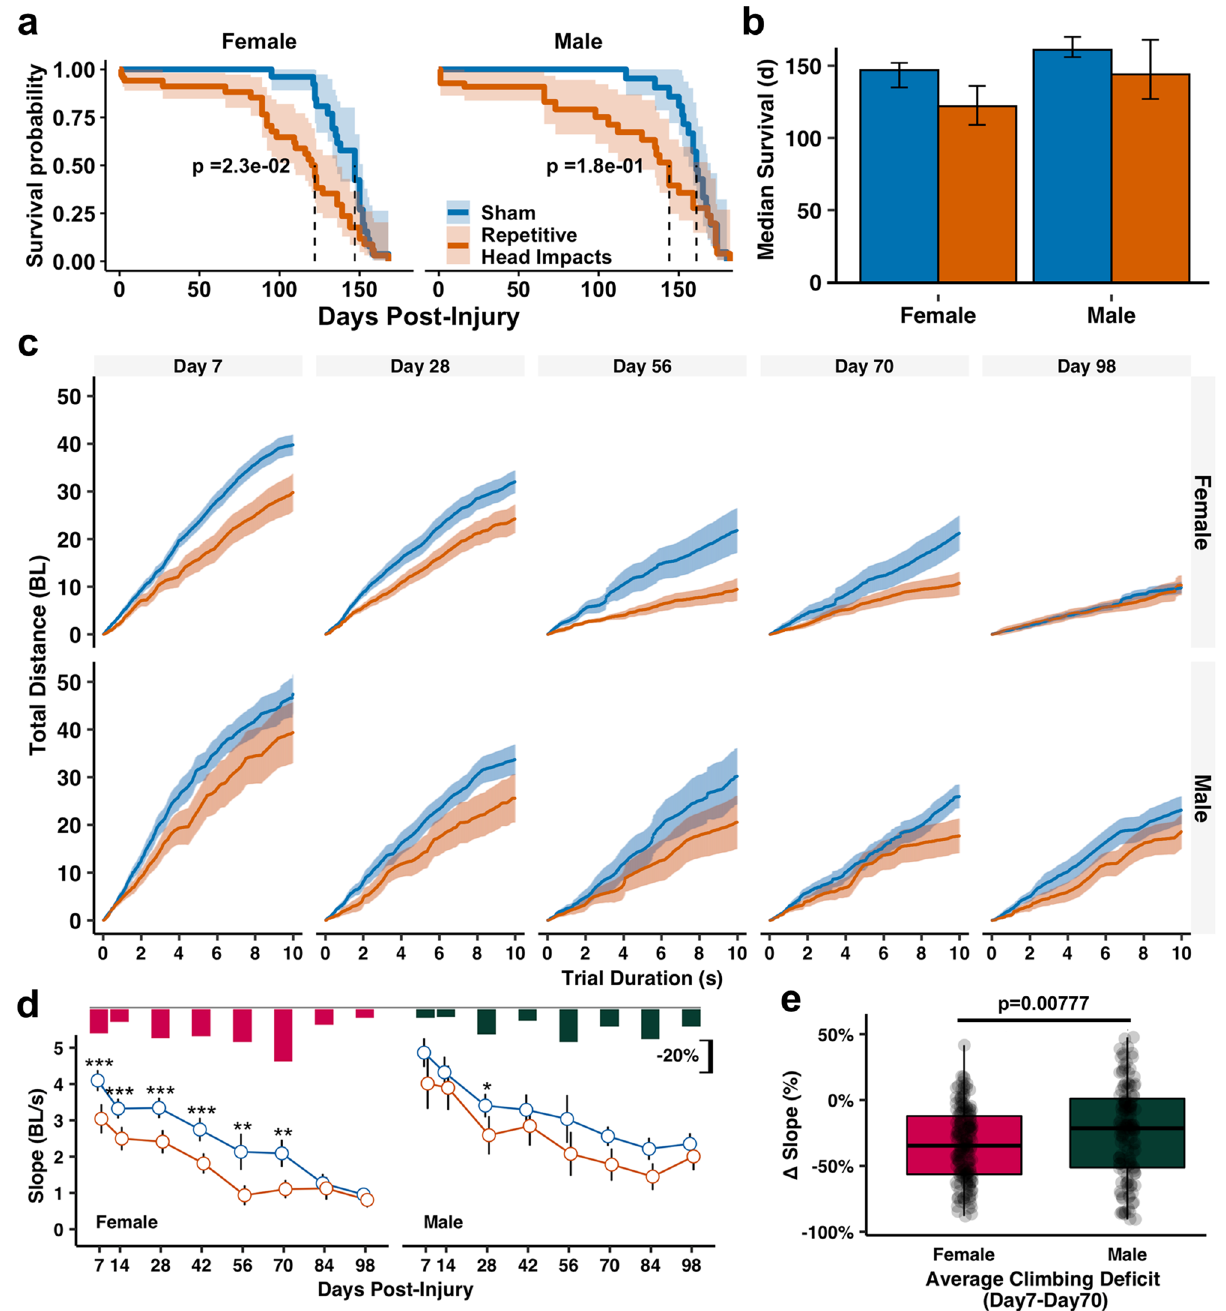
Figure 3. Repetitive head impacts result in a shortened lifespan and long-term behavioral climbing deficits. ( a,b) Repetitive head impacts result in a shortened overall lifespan that is significantly different in injured female flies compared to sham injured flies. Kaplan–Meier p -values were determined using the Mantel-Cox log rank test with Bonferroni correction. ( c–e) Repetitive head impacts exacerbate age-related climbing deficits that are more pronounced in female flies. Plotted values are median with 95% confidence intervals as shaded regions in (c) or error bars in (b,d ) Bar plots in ( d) indicate median relative decrease in climbing performance between injured and sham groups (∆ slope = (Injured Slope-Median Sham Slope)/Median Sham Slope). Boxplots in ( e) contain individually plotted ∆ slope values with whiskers corresponding to the maximum 1.5 interquartile range. Mann–Whitney U test between ( d,e) injured and non-injured groups, with Holm correction: *p < 0.05, **p < 0.01, ***p < 0.001, n ≥ 22 flies per sex/time/injury group except day 56 (n ≥ 11